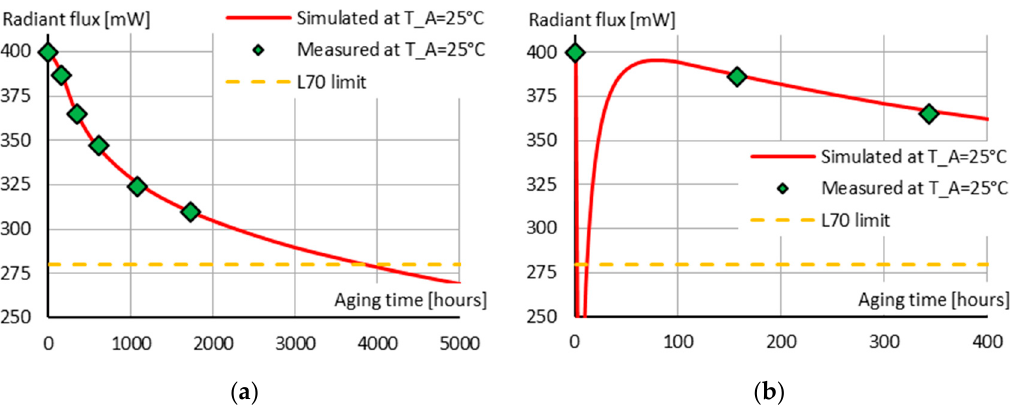
Figure 17. ( a ) Comparison of the simulated and measured total radiant flux maintenance curves of #S07; ( b ) The simulation results of #S07 with higher time resolution—the discontinuity can be clearly seen.